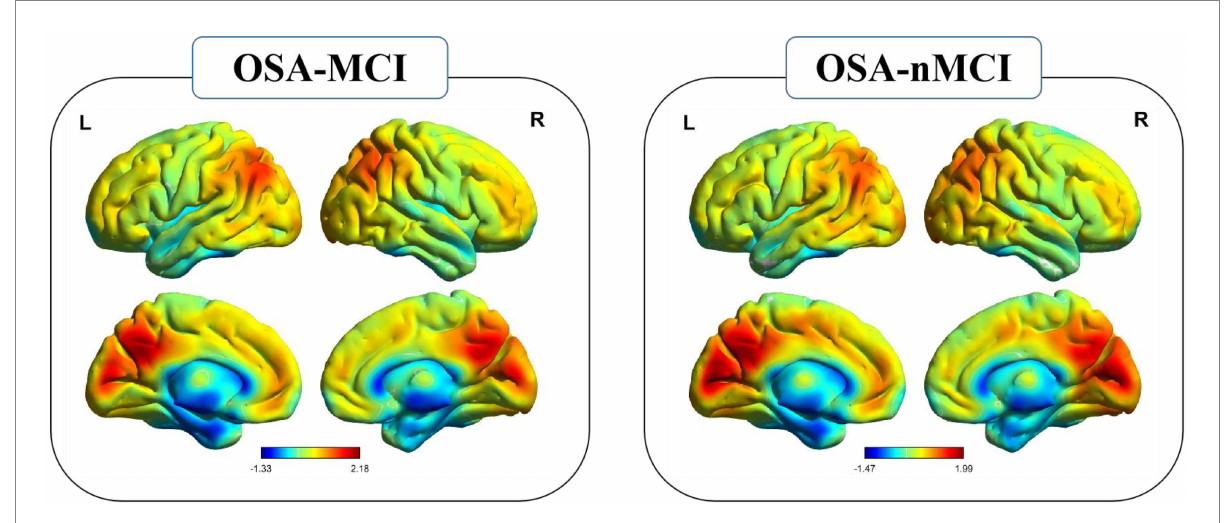
FIGURE 1 Reho spatial patterns at the group mean level of the OSA-MCI and OSA-nMCI